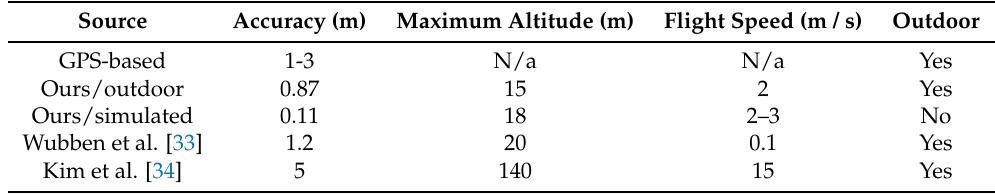
Table 3. The performance of the different